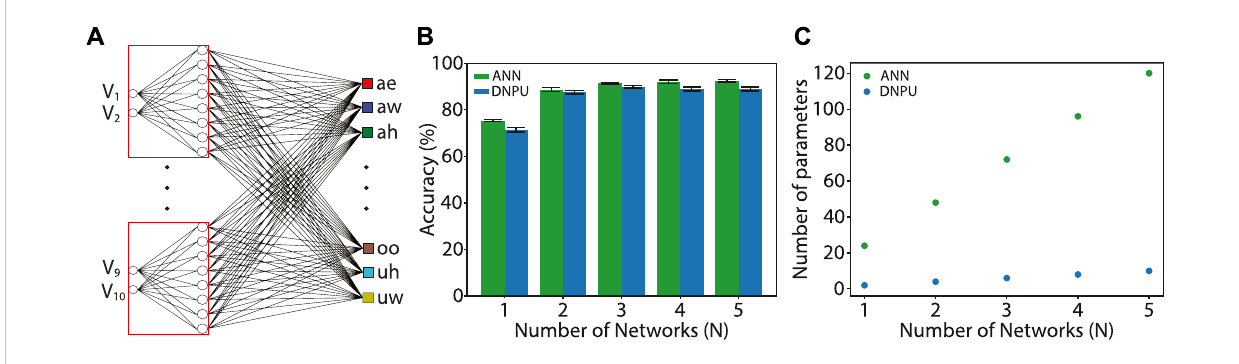
FIGURE 5 Parameter reduction using DNPUs: (A) Same network as in Figure 4C, but with the DNPUs replaced by single-layer fully-connected ANNs (red boxes). (B) Vowel recognition accuracy for the network with ANNs (green) as compared with the network with DNPUs (blue, same data as in Figure 4D). (C) Number of tuneable parameters for the network with ANNs (green) compared with the network with DNPUs